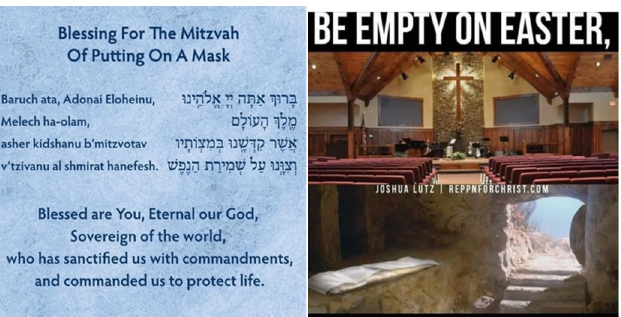
Figure 5. Examples of memes that depict religious communities as advocates of social distancing